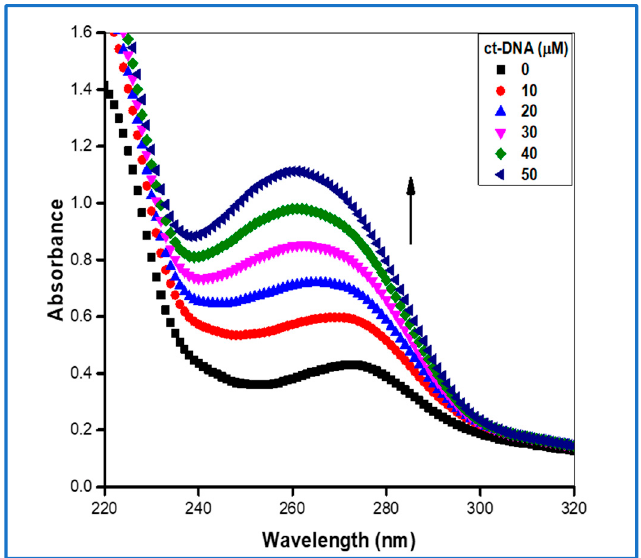
Figure 13. Molecular electrostatic potential surface of the compound 1 ( a ) and compound 2 ( b ) hav- ing regions rich and poor in electrons, as indicated by the colors red and blue.